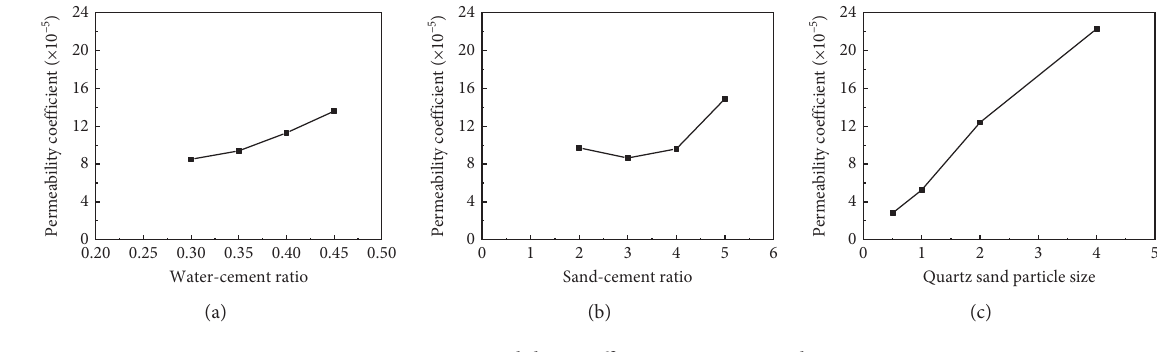
Figure 2: Permeability coefficient sensitivity analysis.